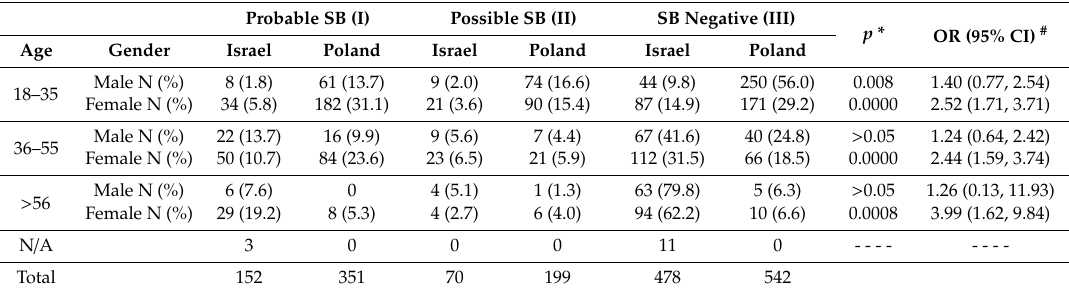
Table 5. Sleep bruxism (SB)